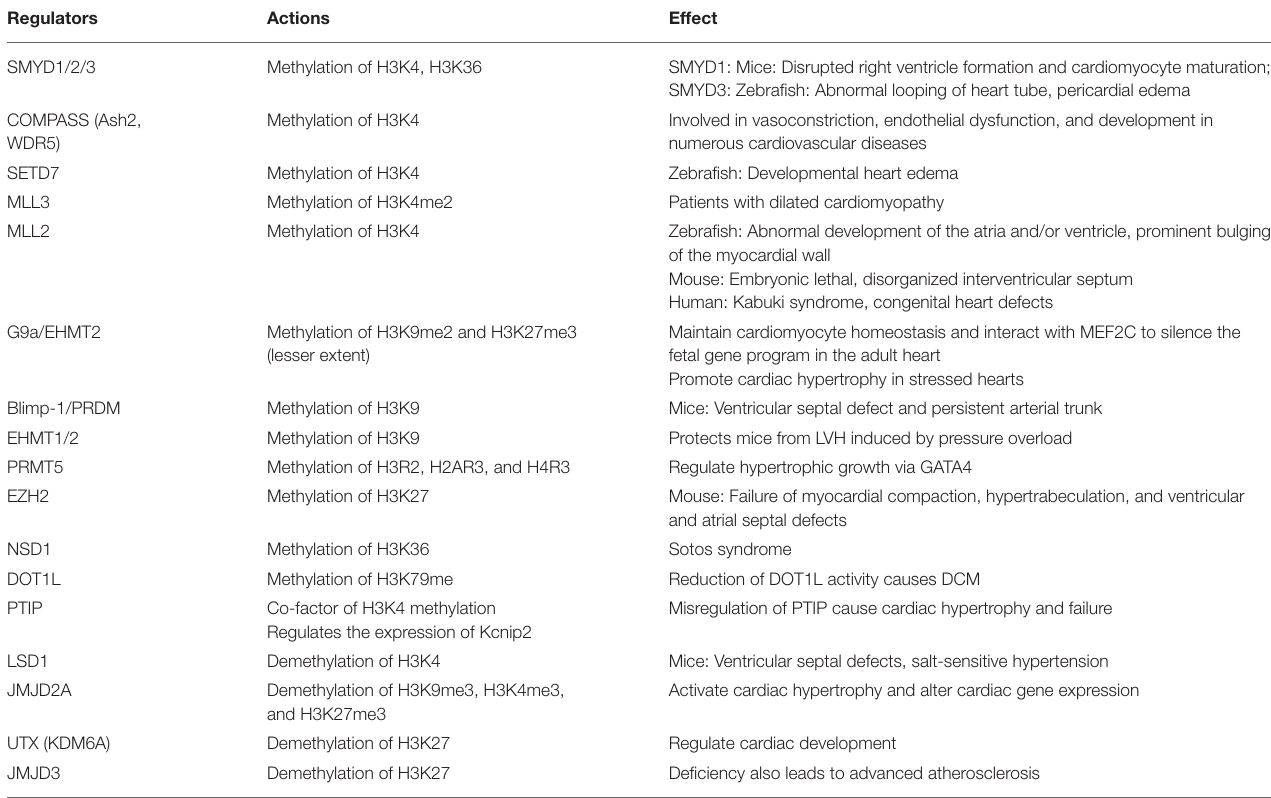
TABLE 1 | The known methyltransferases and demethylases involved in CVDs progression.